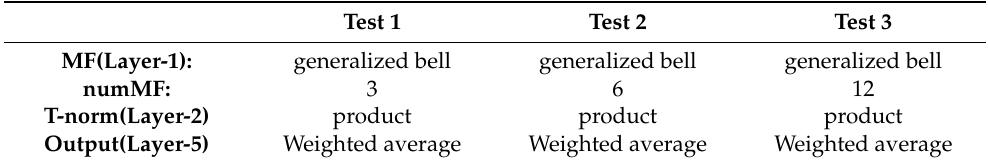
Figure 21. Diagram of different attribution functions in the ANFIS architecture. Table 5. Basic ANFIS setup